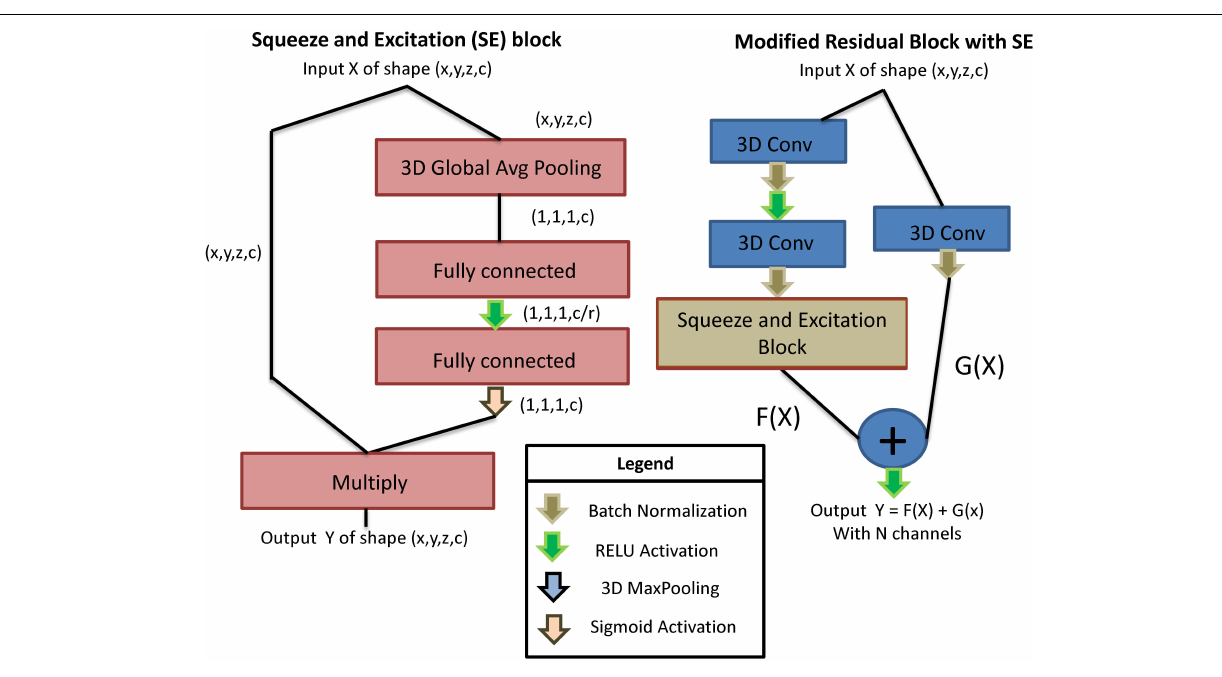
Frontiers in Human Neuroscience |